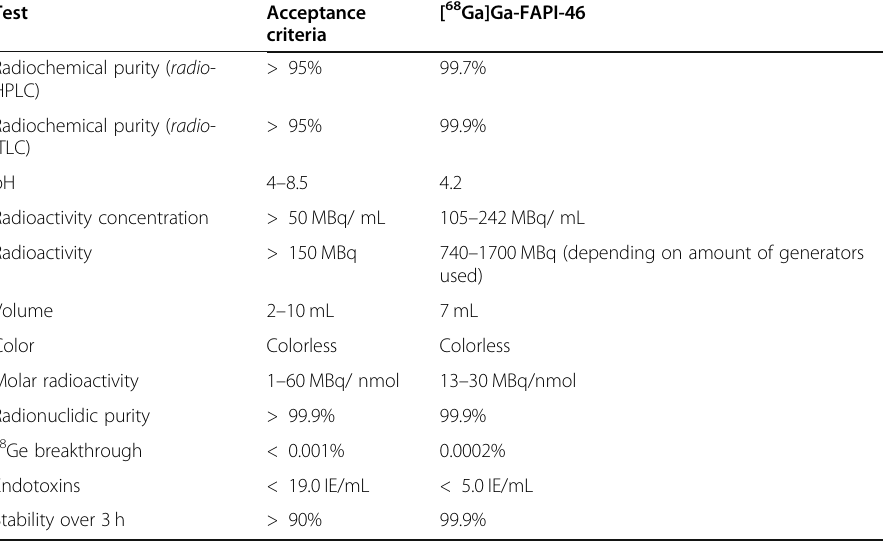
Table 3 Summary of the product specifications for 50 μ g FAPI-46, n =